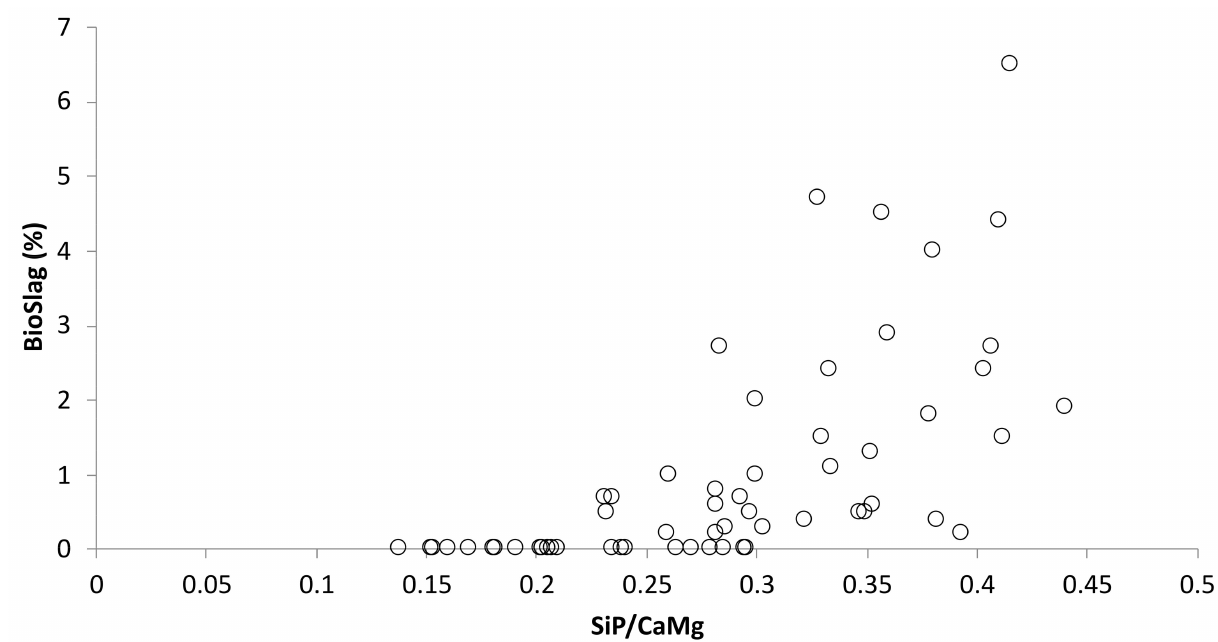
Figure 7. Scatter plot of the SiP/CaMg index and the slagging evaluated by the BioSlag